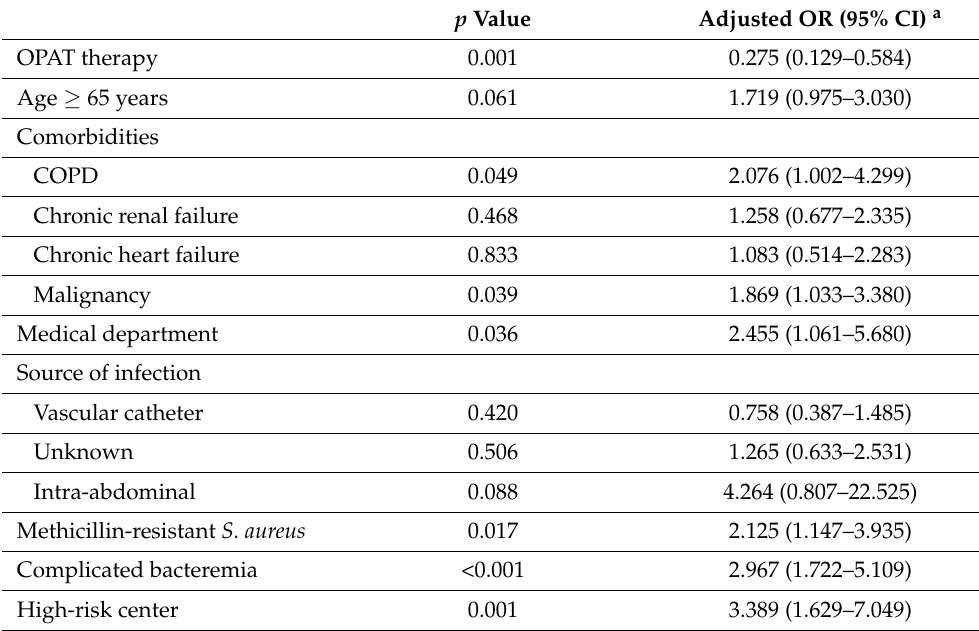
Table 3. Multivariate logistic regression analysis for OPAT program on 60-day treatment failure.